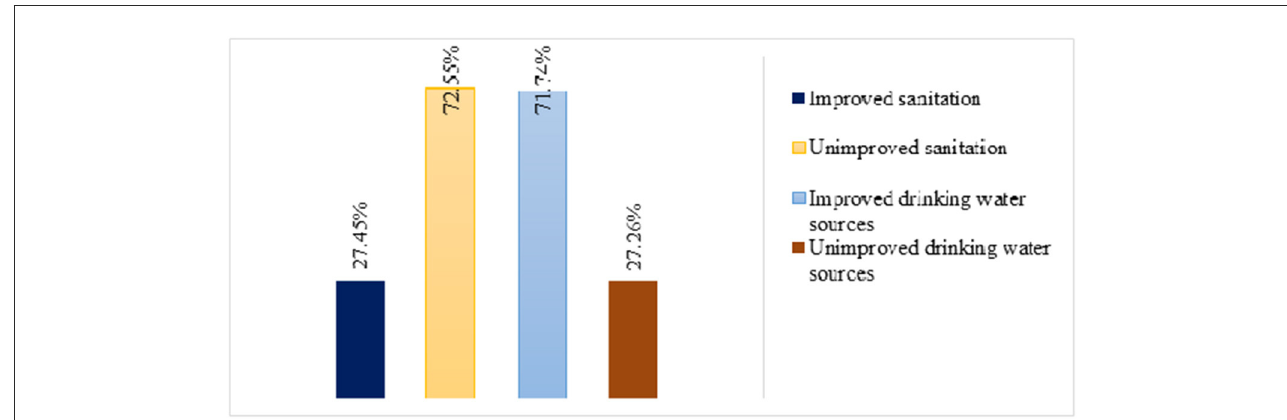
FIGURE2 Level of improved water source and sanitation in Ethiopia from EMDHS 2019